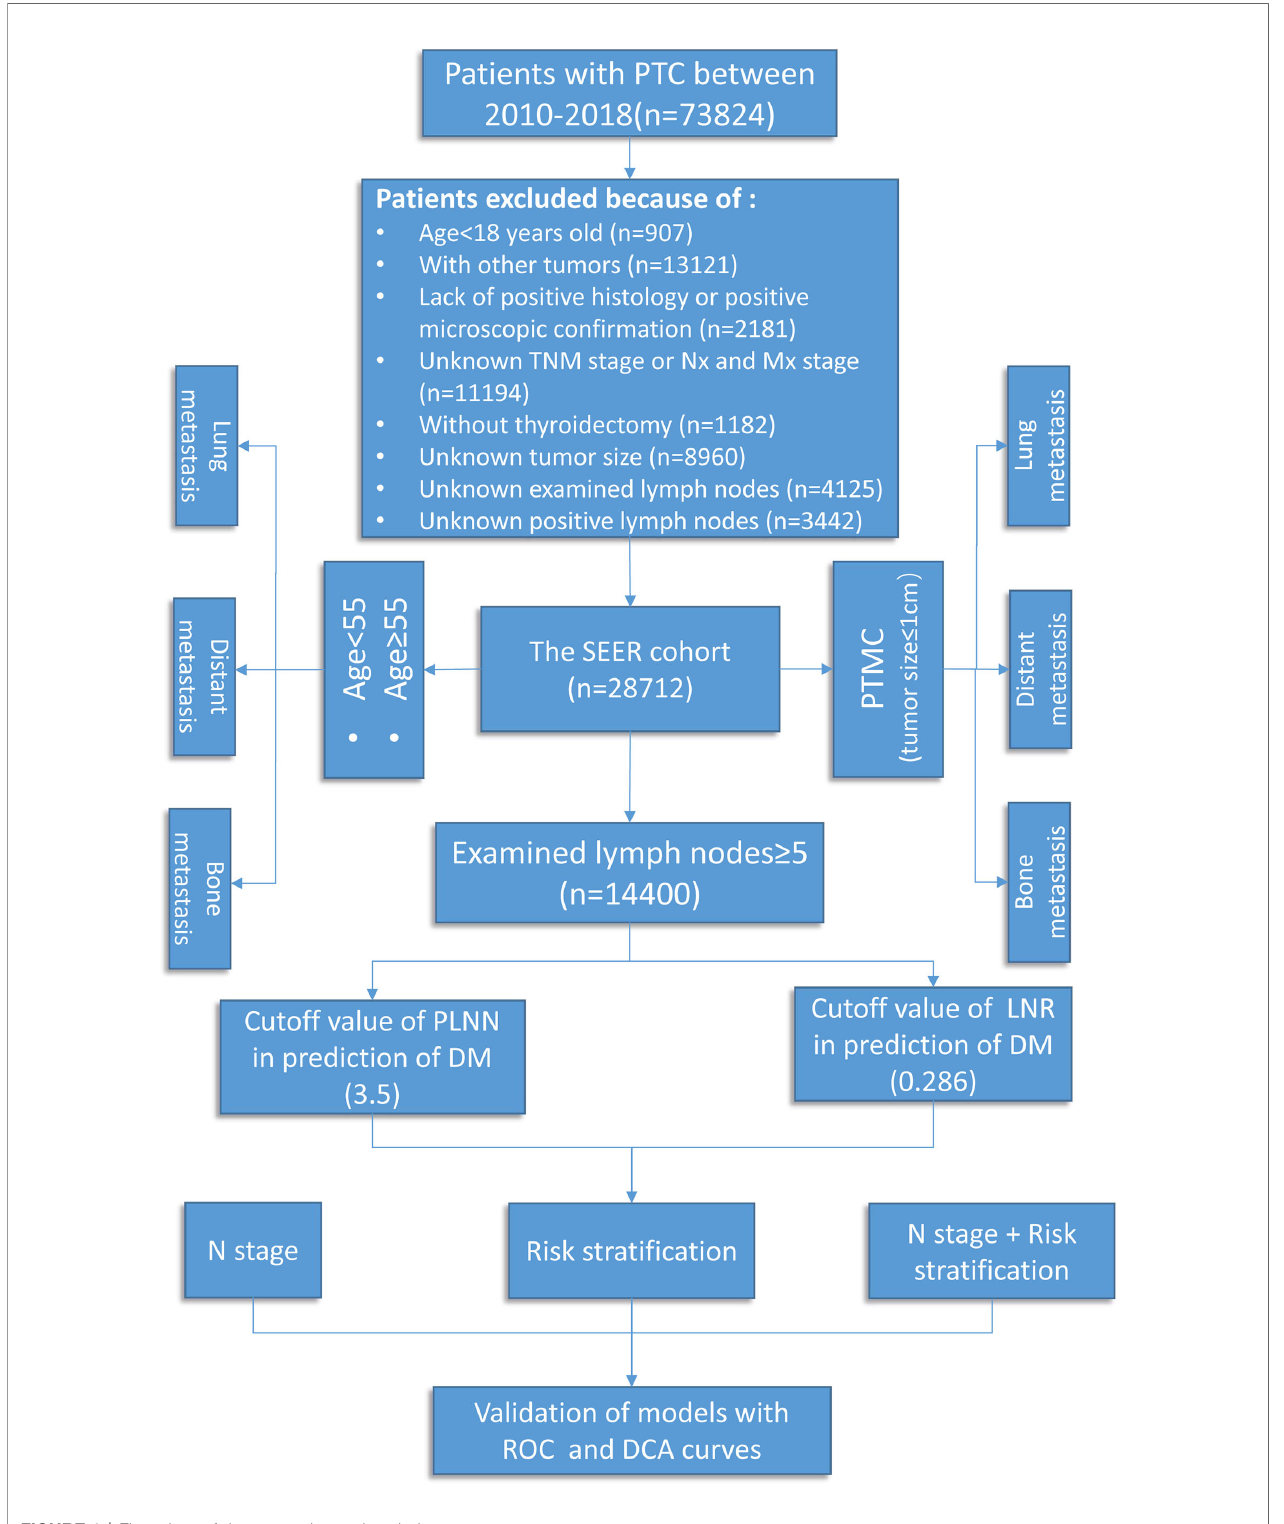
FIGURE 1 | Flow chart of data screening and